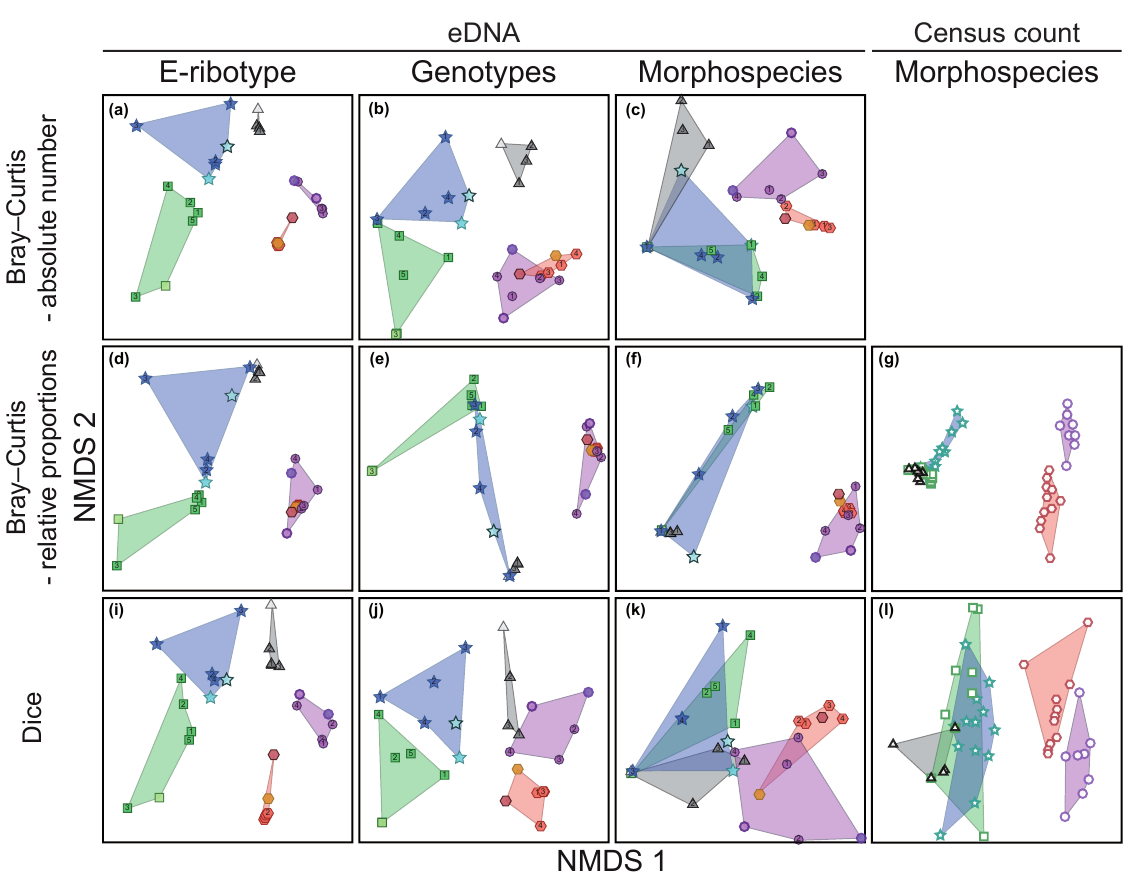
Figure 4. Community structuring of planktonic foraminifera in sedimentary e DNA. Grouping of e DNA and census count samples according to their taxonomic composition using nonlinear multidimensional scaling based on Bray–Curtis (absolute number a–c and relative abun- dances d–g ) and Dice distances (i–l) based on corrected data. The NMDS is provided for the three different degrees of taxonomic resolution (ribotypes, genotypes and morphospecies) for the e DNA samples. As the census count are relative abundances, the Bray–Curtis on absolute value is not provided for the census count assemblages. The area covered by the samples of each region is highlighted. Symbols as in Figs. 1b and